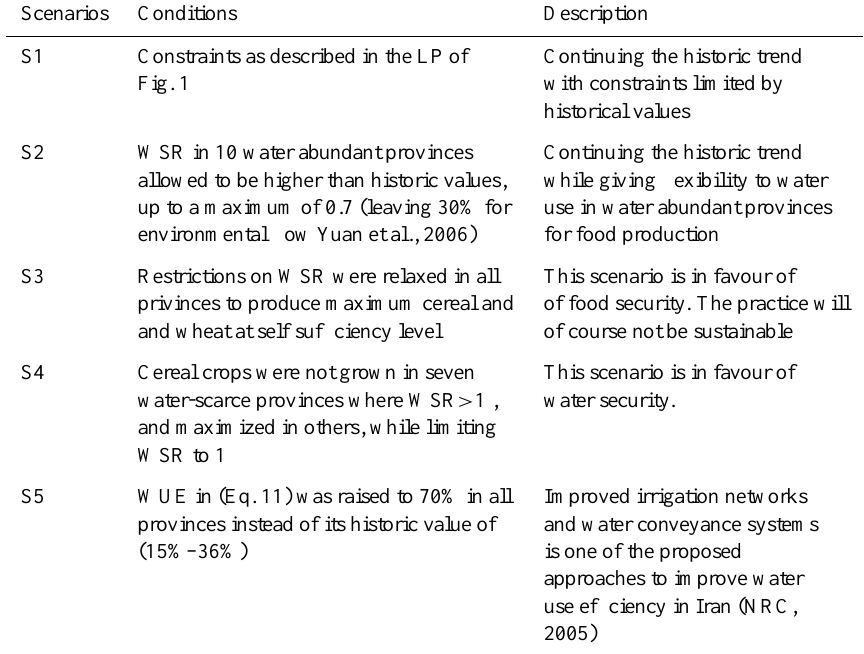
Table 3. Description of the five scenarios modelled in this